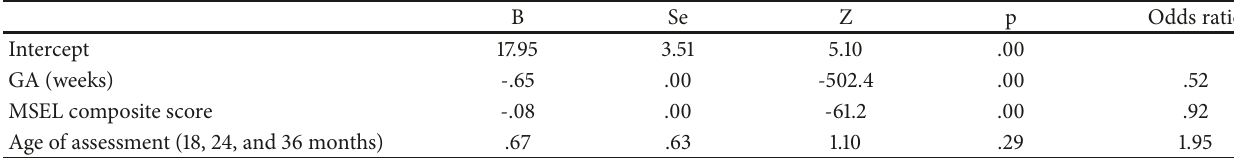
Table 5: Risk for autism spectrum disorder among preterm